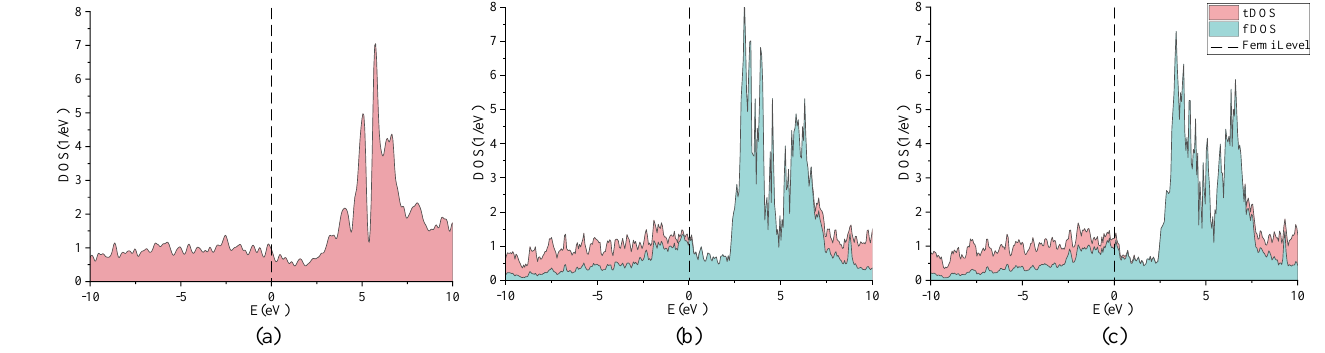
Figure 3. ( a ) Density of states produced by DFT calculations. In ( b , c ), we show the density of states, obtained within the oneshot DFT + DMFT and within the full-charge self-consistent DFT + DMFT + CSC, respectively. tDOS and f DOS signify the density of states corresponding to the lattice and f impurity Green’s function, respectively. All calculations were carried out in the Fm3m phase of LaH 10 at 400